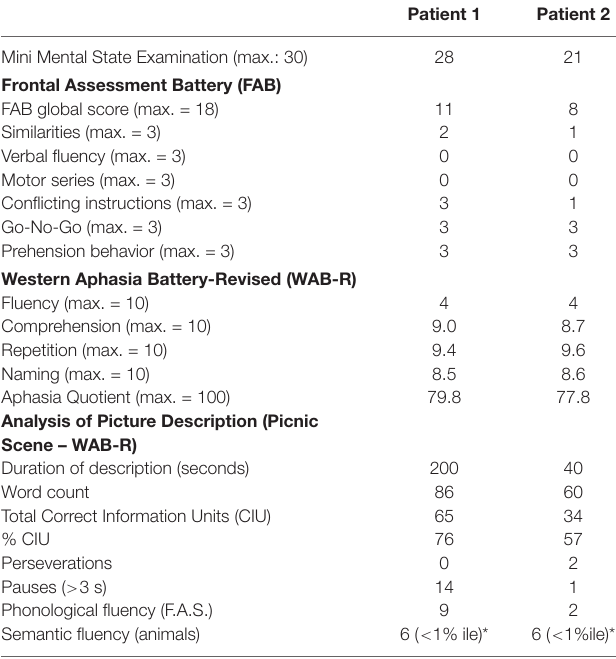
TABLE 2 | Testing of cognition and language.